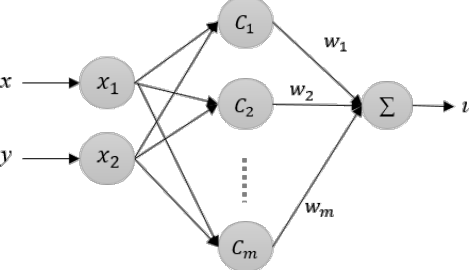
Figure 9. Diagram of radial basis function neural network (RBFNN) architecture.